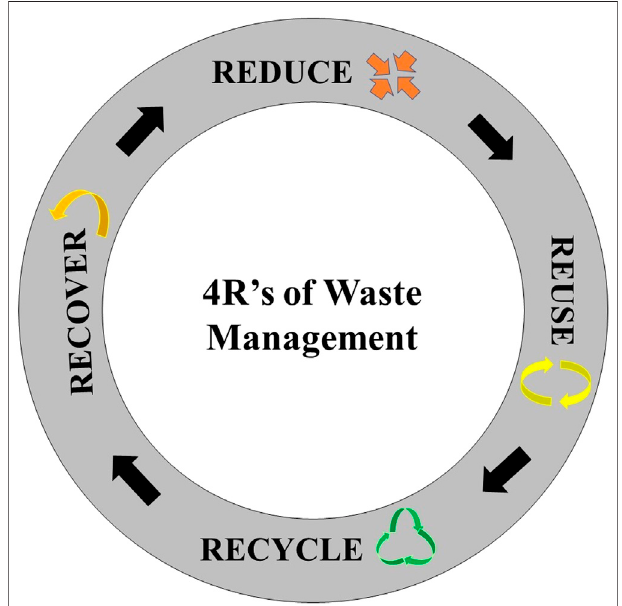
FIGURE 5 | 4R ’ s concept for good waste management. Reduce, reuse, recycle, and recover are the four good waste management practices sequentially organized in order of importance. The foremost goal is to reduce or avoid the minimum purchase of materials that are harmful to the environment. Reuse suggests the use of materials again for other purposes rather than disposing off unscienti fi cally. Recycle emphasizes reusing waste materials (like plastic, metal, and e-waste) by recycling them into new products. Recover highlights the processing of waste to obtain valuable products. Hence, the adoption of 4R ’ s concept can contribute to good waste management practices in the IHR.